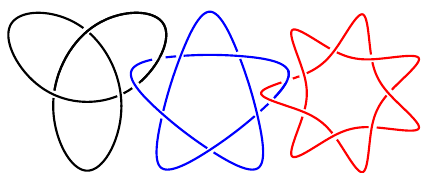
Figure 10. The link L obtained by \Hopf-linking" K 3 ; 2 (black), K 5 ; 2 (blue), and (3 ; 2) ; (5 ; 2) ; (7 ; 2) K 7 ; 2